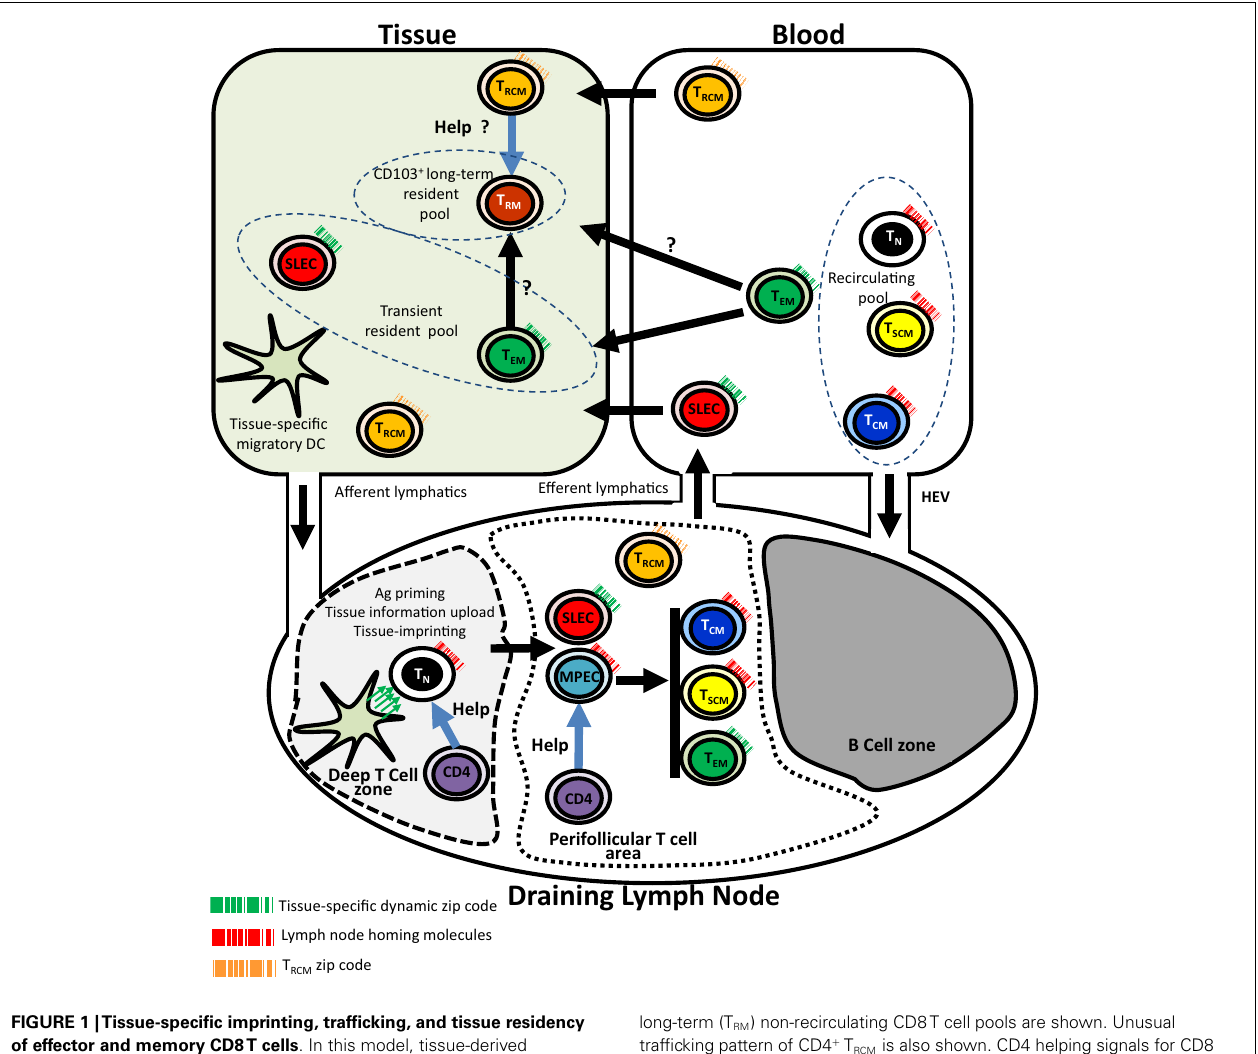
FIGURE 1 |Tissue-specific imprinting, trafficking, and tissue residency of effector and memory CD8T cells . In this model, tissue-derived migratory DC imprints tissue-specific homing pattern (symbolized by the green arrows) in naiveT cell during priming in the context of the deepT cell zone of the draining lymph node. PrimedT cells including SLECs and MPECs relocalize into perifollicularT cell area.While SLECs migrate into tissues through the blood, MPECs complete their differentiation into memory subsets. Recirculating (T N ,T CM ,T SCM ), transient (SLECs,T EM ), and